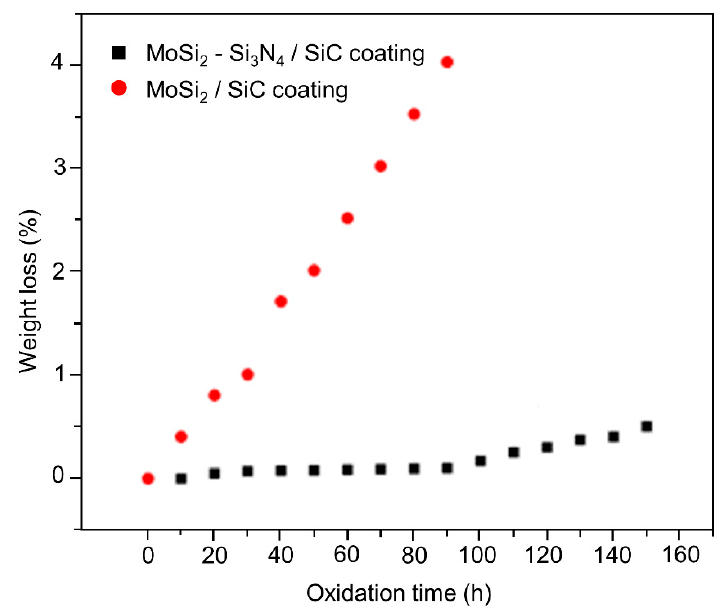
Figure 8. Isothermal oxidation curves of MoSi 2 -Si 3 N 4 / SiC-coated C / C composites in the air at 1773 K.